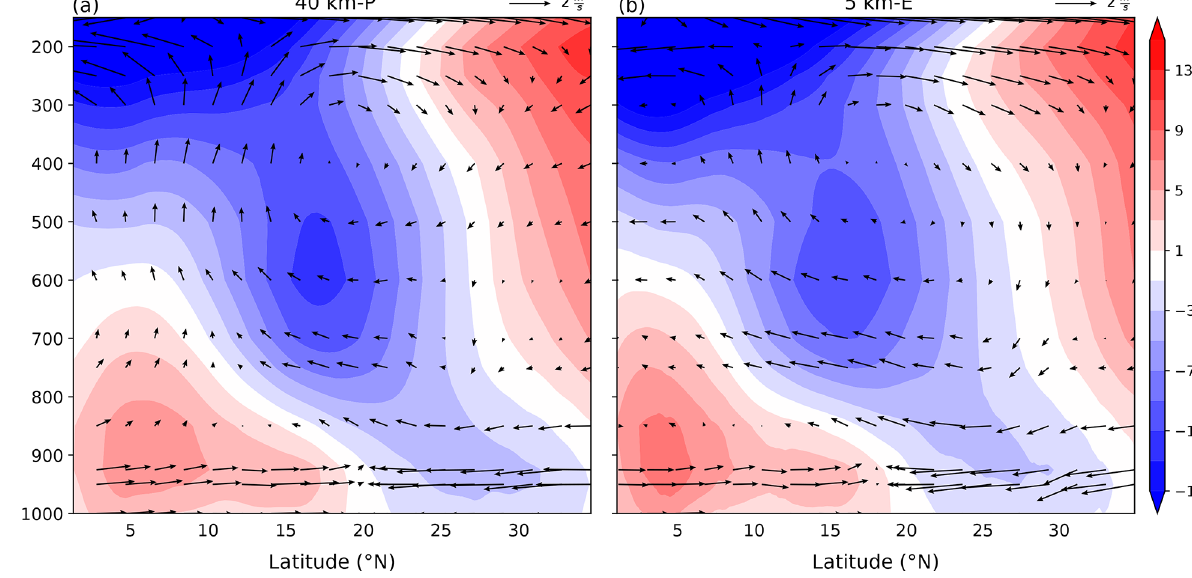
Figure 6. JAS mean cross section of the zonally averaged wind field for the 40km-P (a) and for the 5km-E simulation (b) . The shading shows the zonal wind in ms − 1 . The vectors show the meridional and vertical wind field (ms − 1 ), where the vertical wind component is multiplied with 100 to make the vectors better visible. The mean is taken over all points of the dashed “WA domain” outlined in Fig.